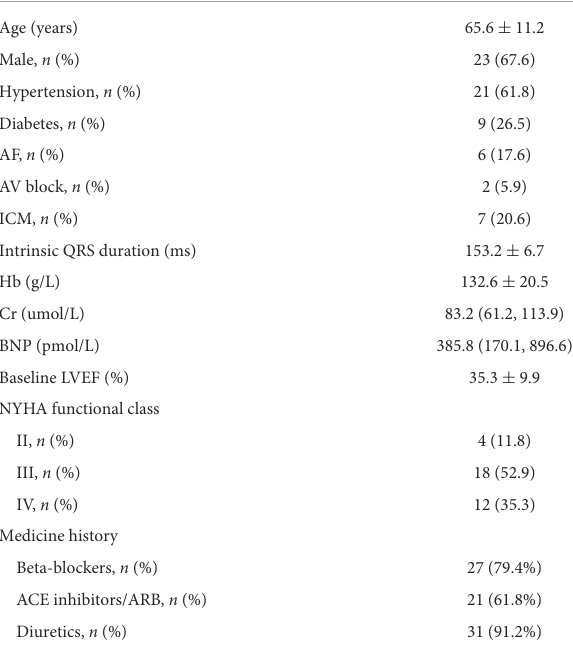
TABLE 1 Baseline